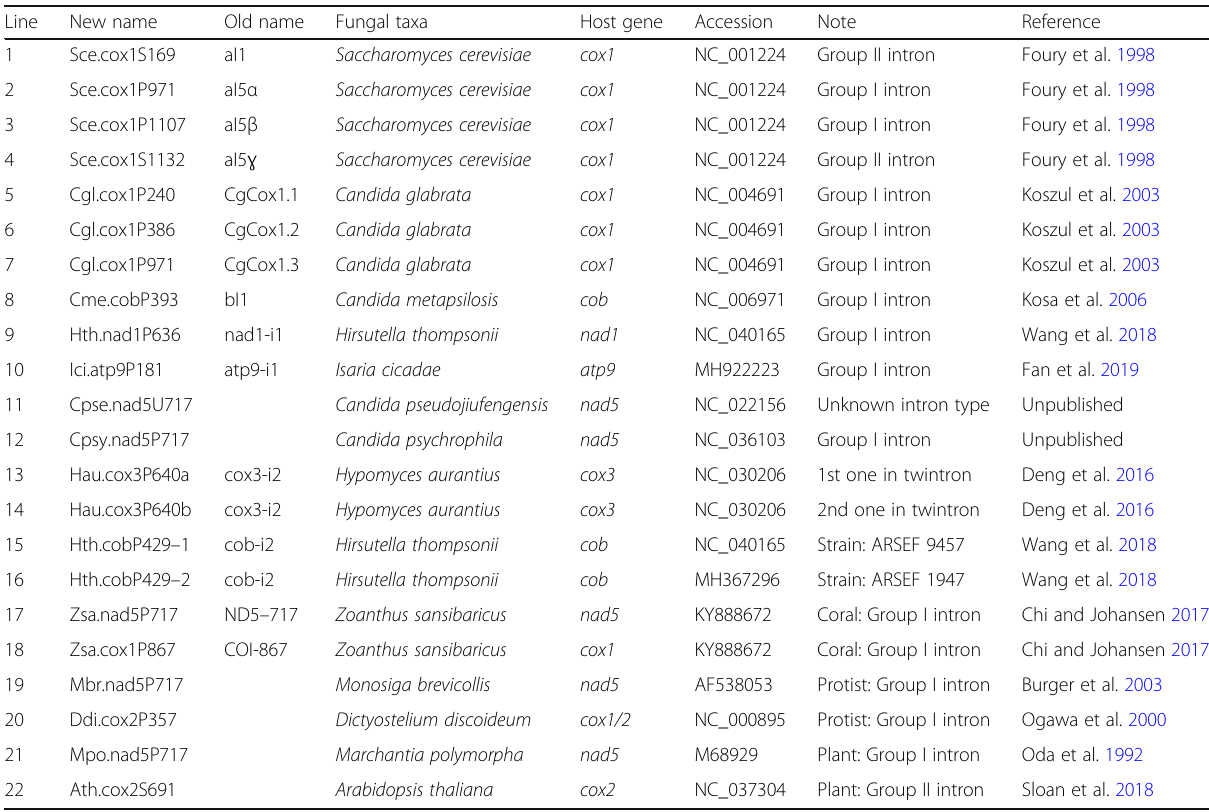
Table 2 Representative examples of the new nomenclature of introns in protein-coding genes a